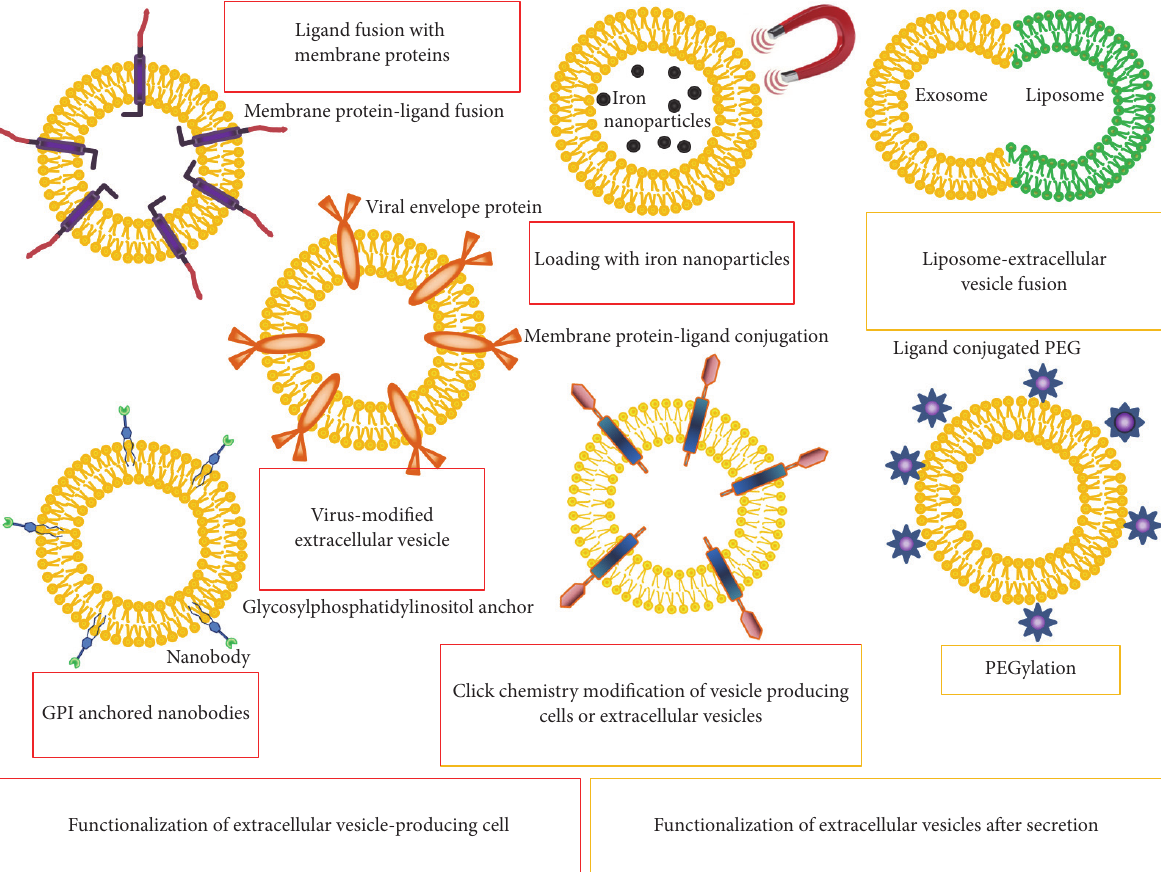
Figure 2: Schematic representation of different methods to promote tissue- or cell-type-specific targeting of extracellular vesicles (EVs). EVs can be targeted to particular cellular receptor either by modifications of EVs-producing cells (red squares) or modification of EVs after secretion (yellow squares). In the first case, EVs-producing cells can be modified: expressing ligands, peptides, or viral-derived envelop proteins in the outer portion of a transmembrane protein; loading cells with iron oxide particles to allow for magnetic targeting. Alternatively, secreted EVs can be modified linking cell-specific peptides to the EVs surface via association with polyethylene glycol (PEG) polymer chains or by EVs-liposome fusion. Click chemistry can be used to modify both EVs-producing cells and purified